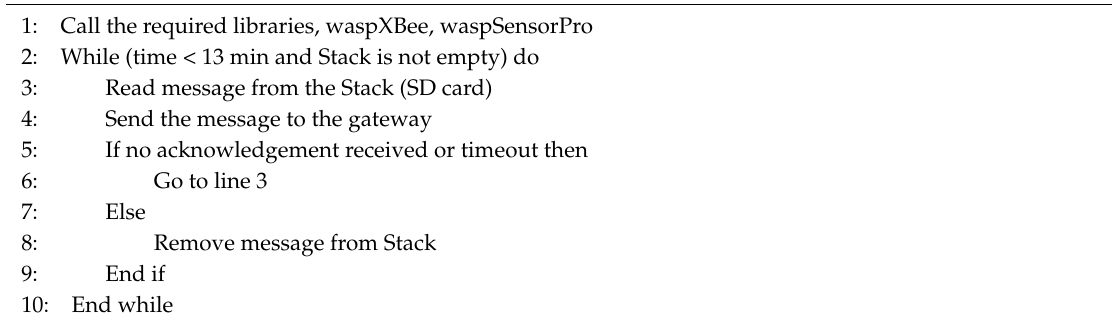
Algorithm 2. Pseudo code at the sensor node for resubmission of unsuccessfully transmitted